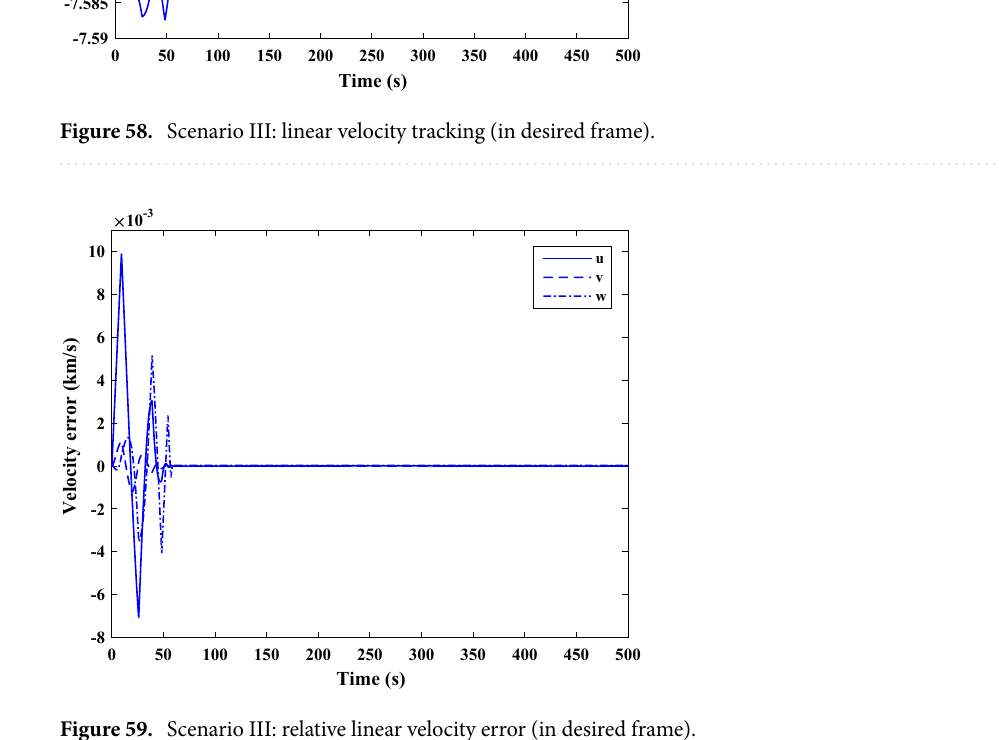
Figure 59. Scenario III: relative linear velocity error (in desired frame).